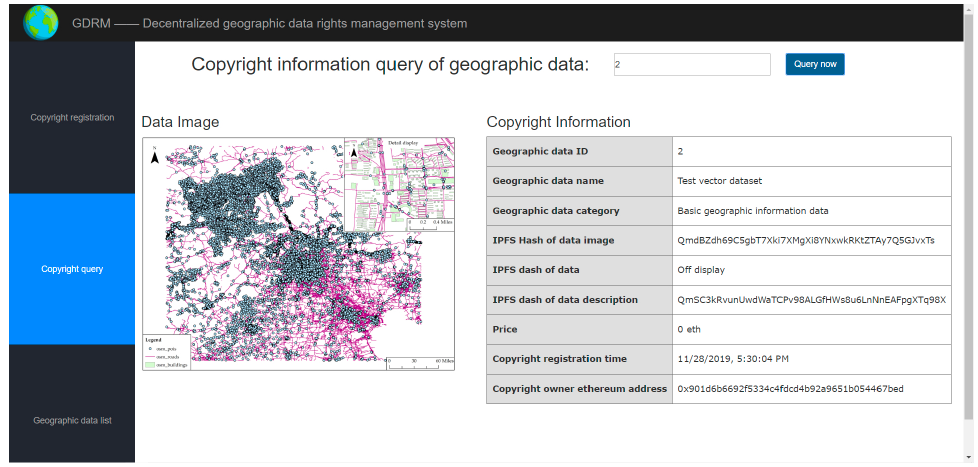
Figure 6. Copyright information query interface.